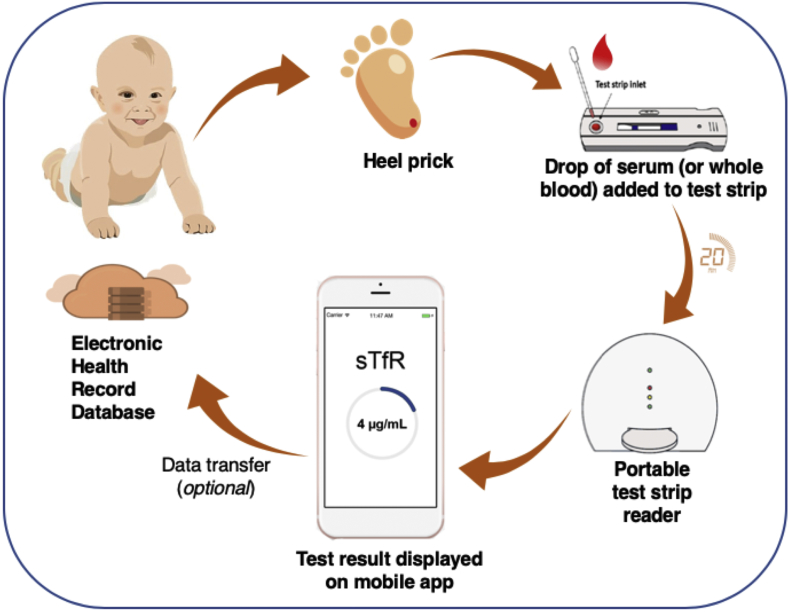
Technology components and testing protocol.